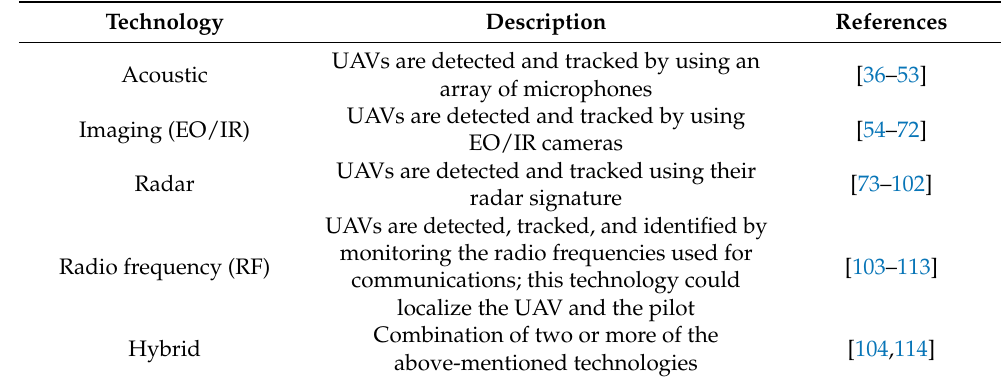
Table 4. Technologies used for drone detection in